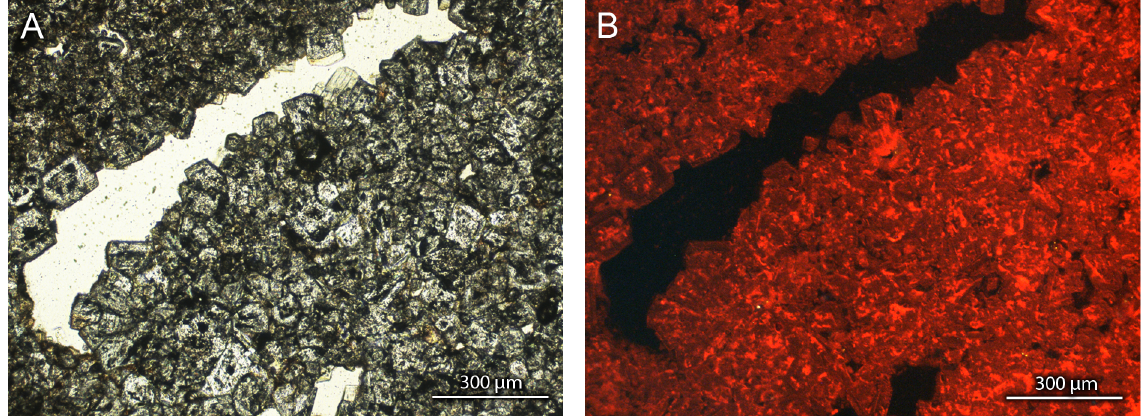
Fig. 11. Paired thin section photomicrographs of type 5 dolomite in light microscope ( A ) and cathodoluminescence ( B ). The rock- penetrating fracture is without any rimming features. Tsiistre drill core, 55.5 m, GIT